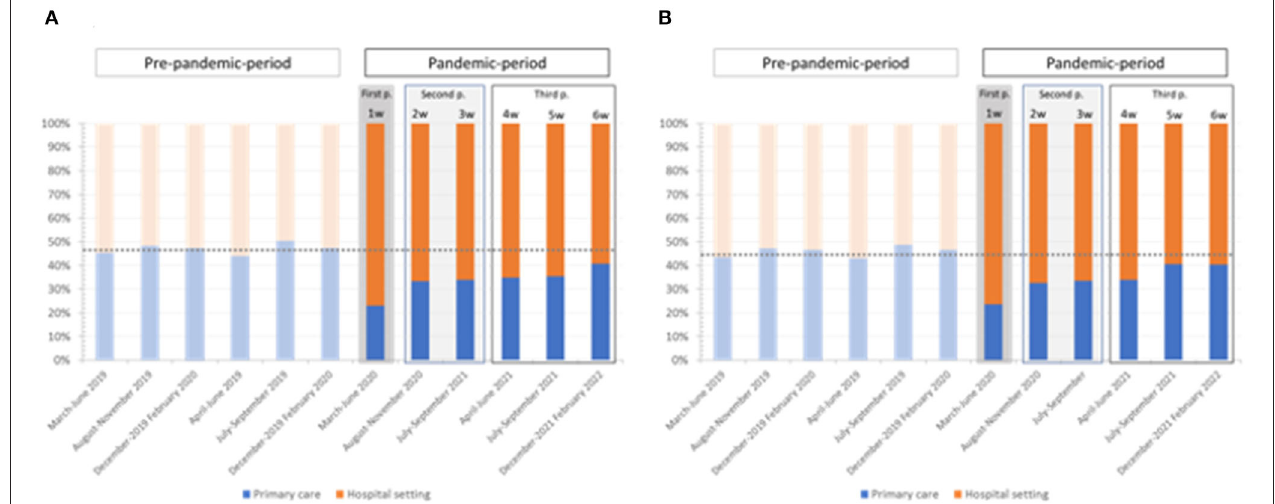
FIGURE 1 | Percentage of samples received for HCV (A) and HIV (B) screening according to primary care or hospital setting origin. Dashed gray lines represent the mean percentage in pre-pandemic for samples from primary care (47% for HCV and 45% for